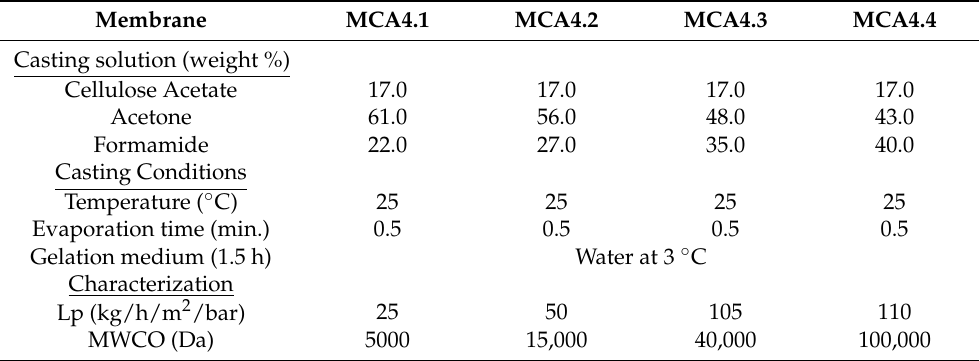
Table 1. Casting solution compositions and film casting conditions. Main characterization parameters of membranes.